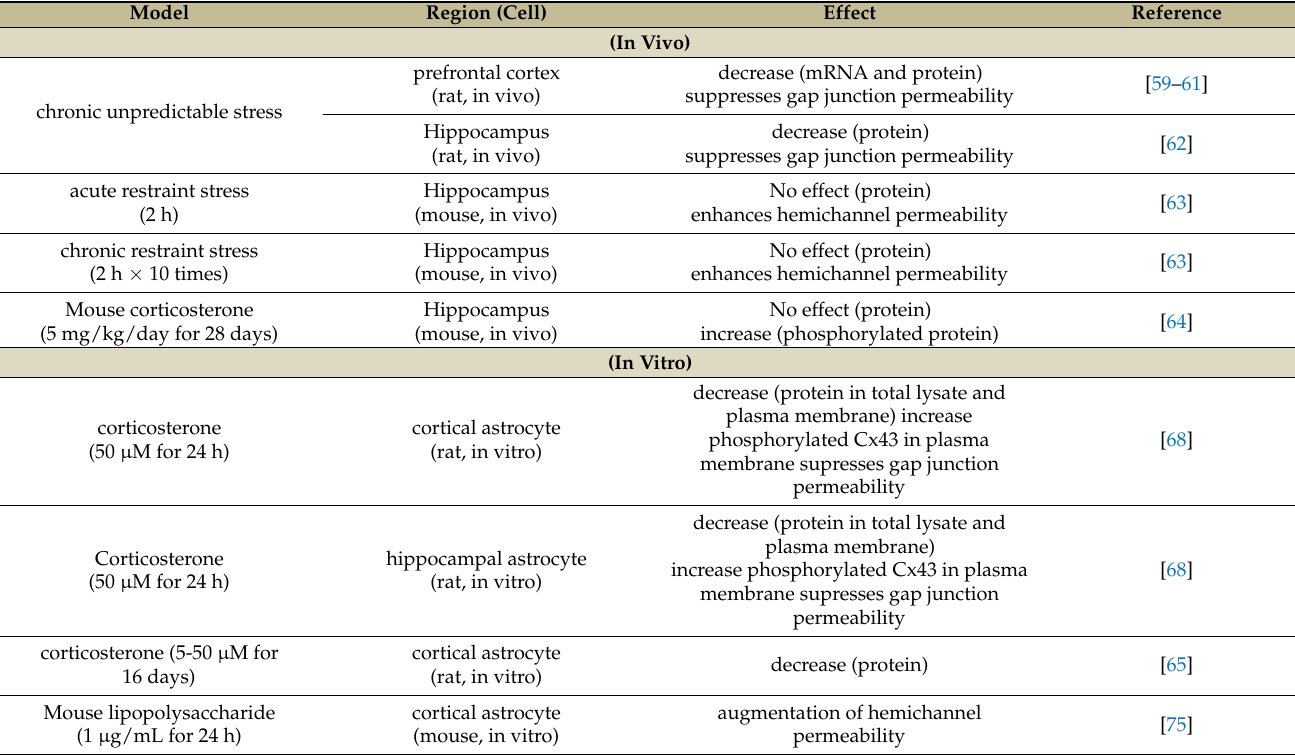
Table 2. Abnormalities of Cx43 expression and function of Cx43 in experimental models of